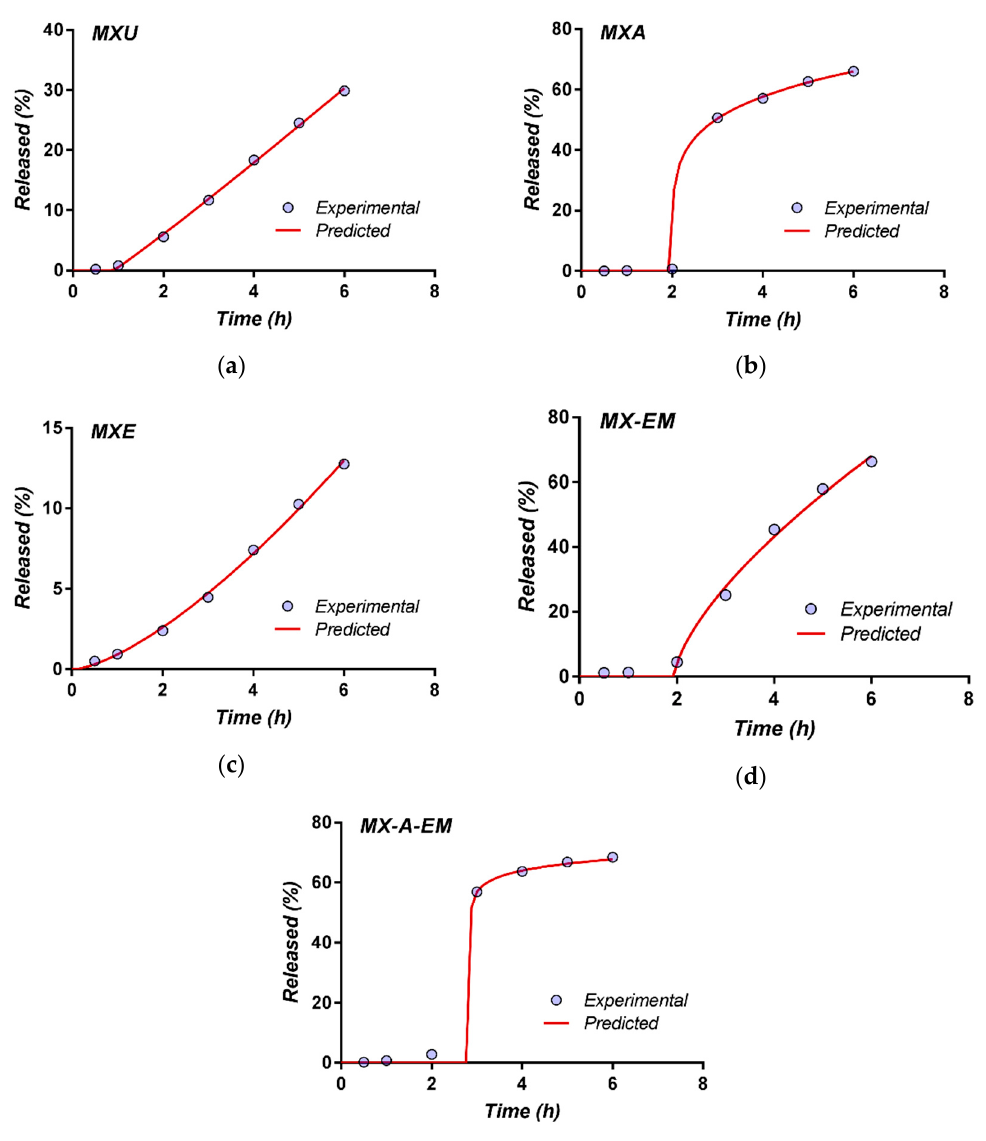
Figure 13. Kinetic modeling of dissolution profiles of the meloxicam multi-particulate systems using the Korsmeyer-Peppas model ( a ) MXU; ( b ) MXA; ( c ) MXE; ( d ) MX-EM; ( e ) MX-A-EM.